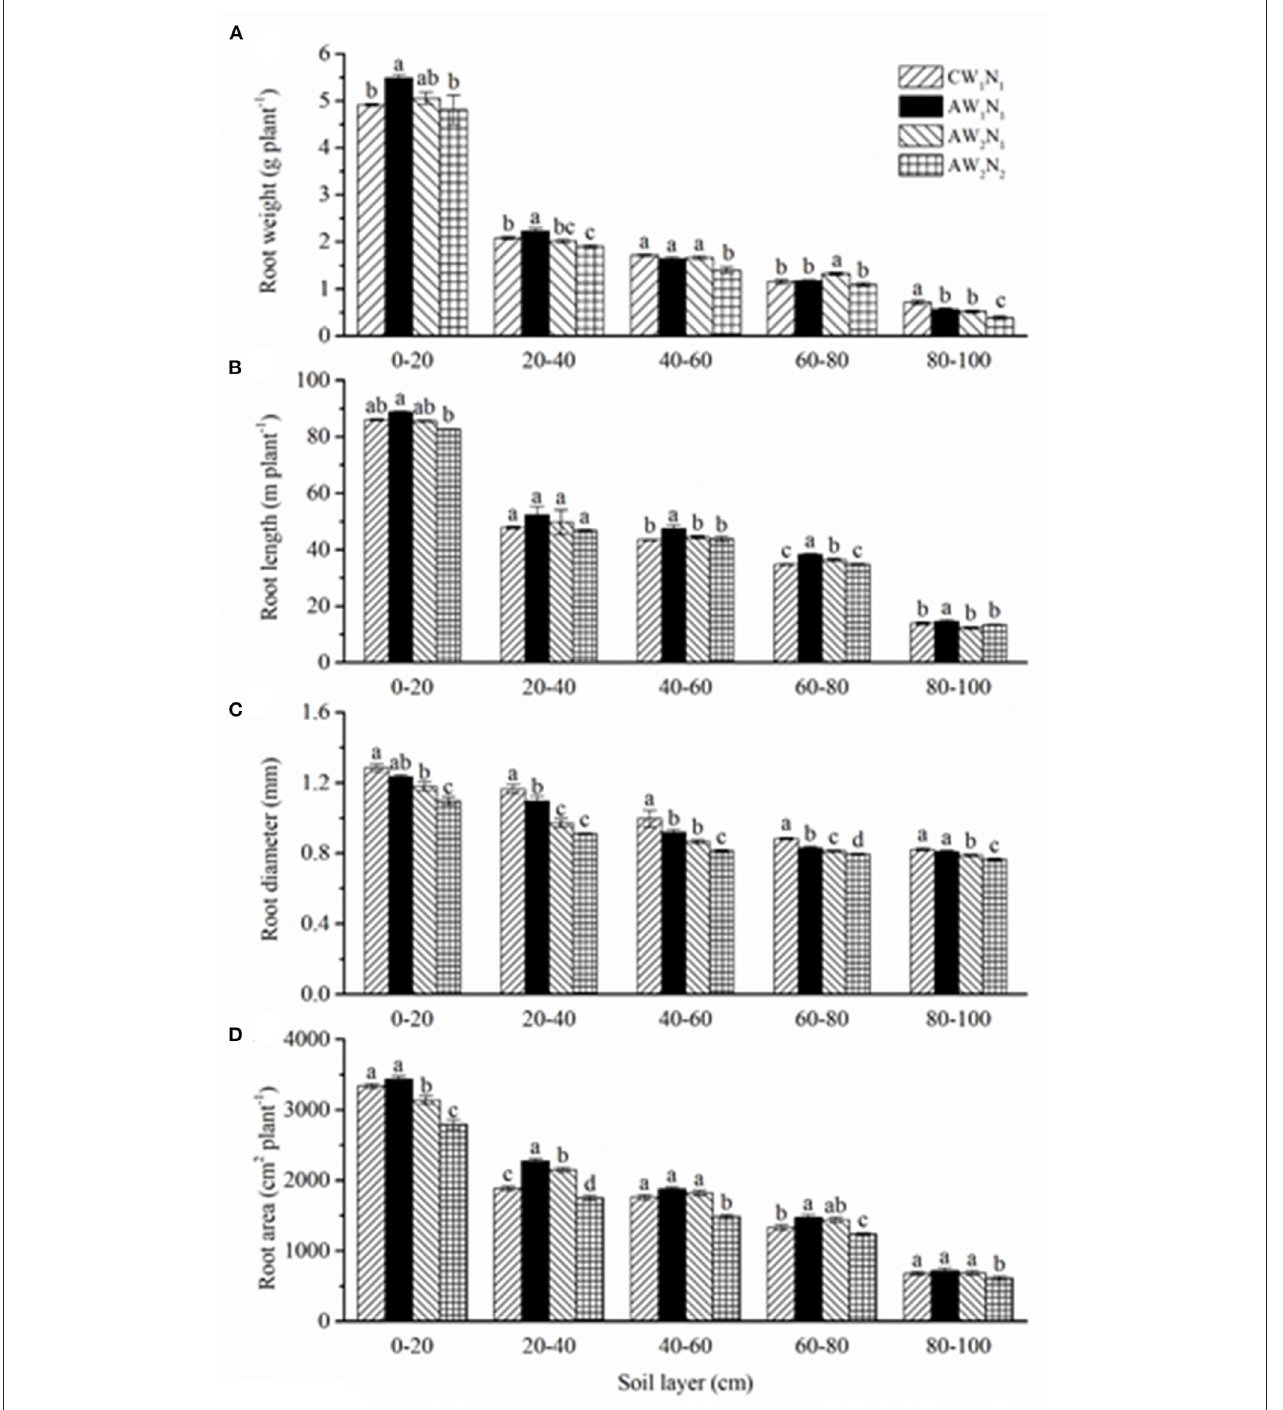
FIGURE 3 | The effects of irrigation and N supply on root growth and distribution in soil layers under alternate partial root-zone drip irrigation. (A) Root weight (g plant − 1 ), (B) root length (m plant − 1 ), (C) toot diameter (mm) and (D) root area (cm 2 plant − 1 ). Values are the means ± SE. Different lowercase letters in the columns denote significant differences among the treatments ( P ≤